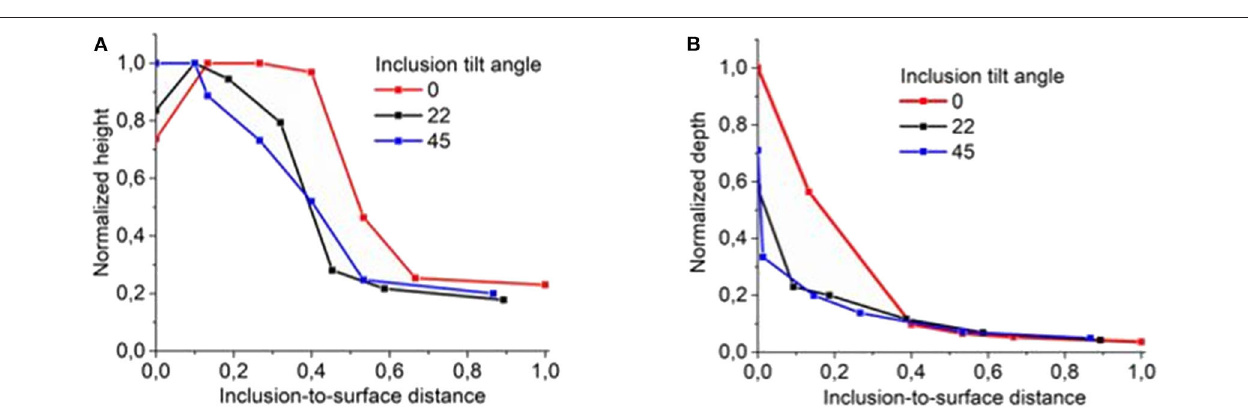
FIGURE 7 | Normalized heights (A) and depths (B) of the surface humps and dimples vs. inclusion orientations and positions d below the